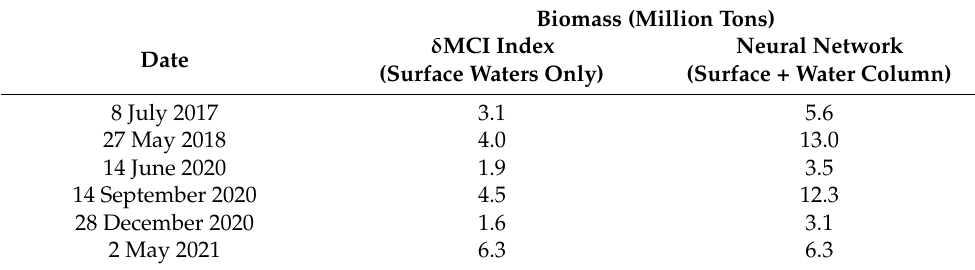
Table 4. Comparison of the Sargassum biomass (in million tons) derived from both the δ MCI and the neural network approaches for the OLCI image